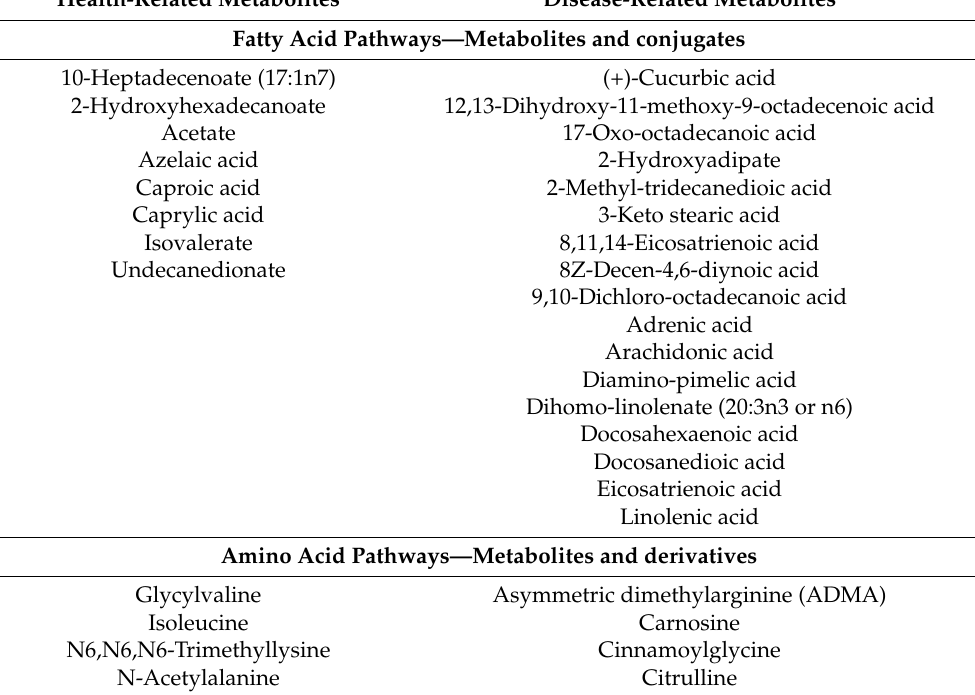
Table 2. Disease/health-related metabolites and chemical